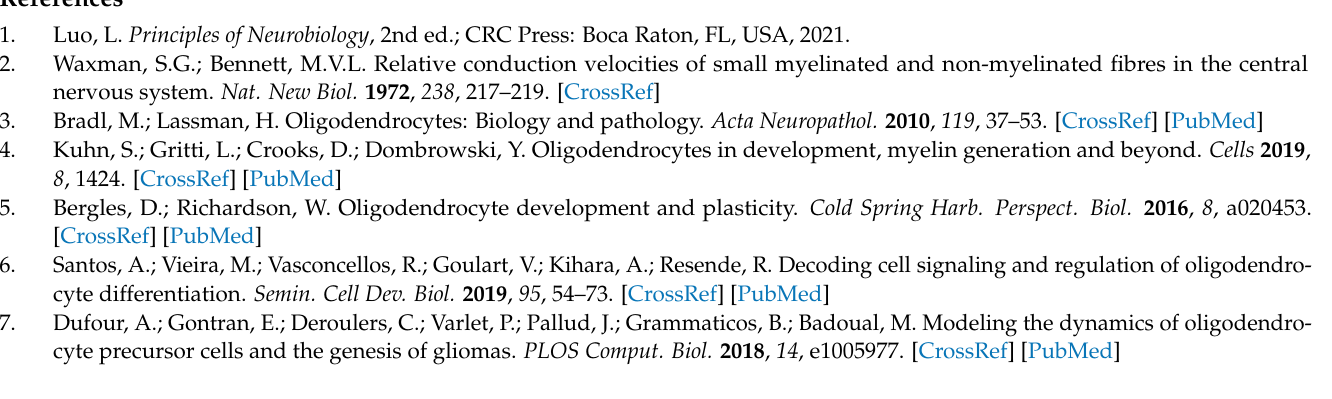
Figure A3. Periodic (sustained oscillation) solution for mOlig2 (solid line), miRNA, mSox9 and mSox10 (solid line) arising from system (1) when I 1 = I 2 = 0.01 and k 2 = 0.2. The solution for mOlig2 has a form of relaxant (fast-slow phases) oscillation.